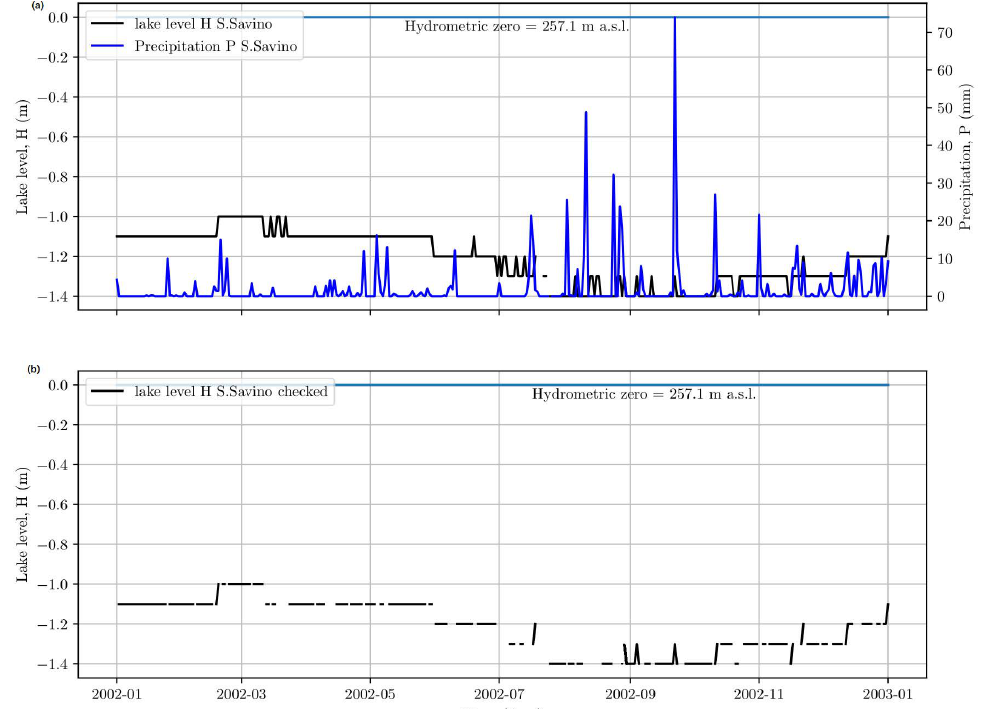
Figure 4. Cross-check between precipitation and level of the Trasimeno lake at S. Savino for the period January 2002–January 2003. ( a , b ) In Figure 3a, the unchecked lake level is reported together with precipitation, whereas in Figure 3b the validated level is shown.